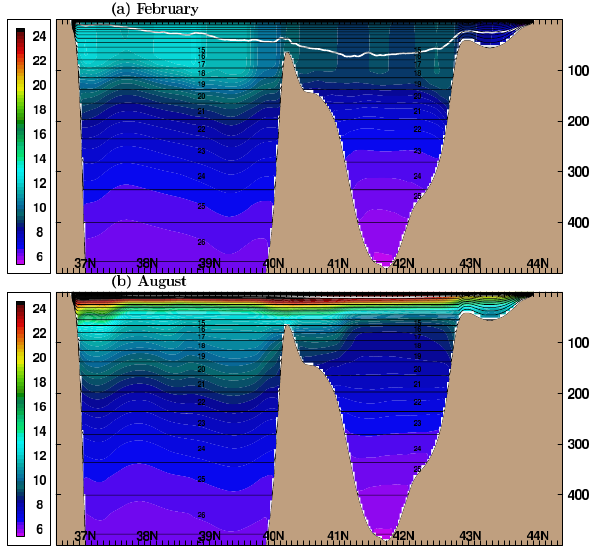
Figure 4. Model-derived monthly mean temperature at 50 ◦ E ( (a) February (b) August).